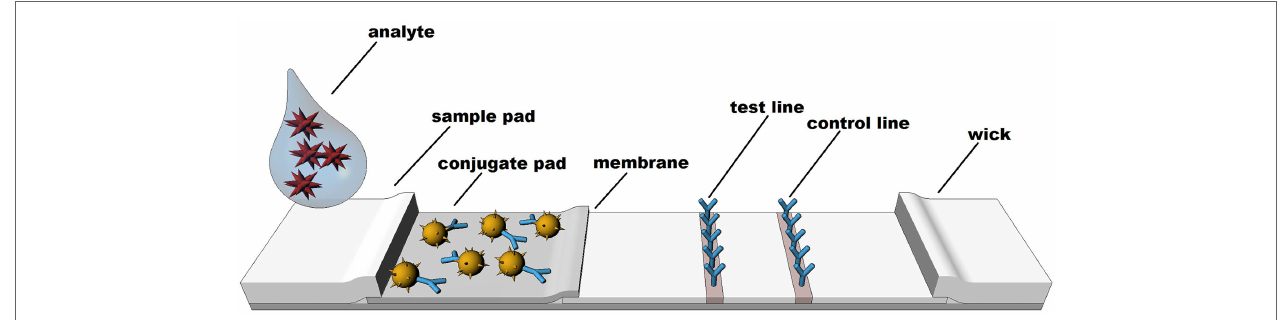
FiGURe 1 | Structure and sequence of a typical lateral flow test